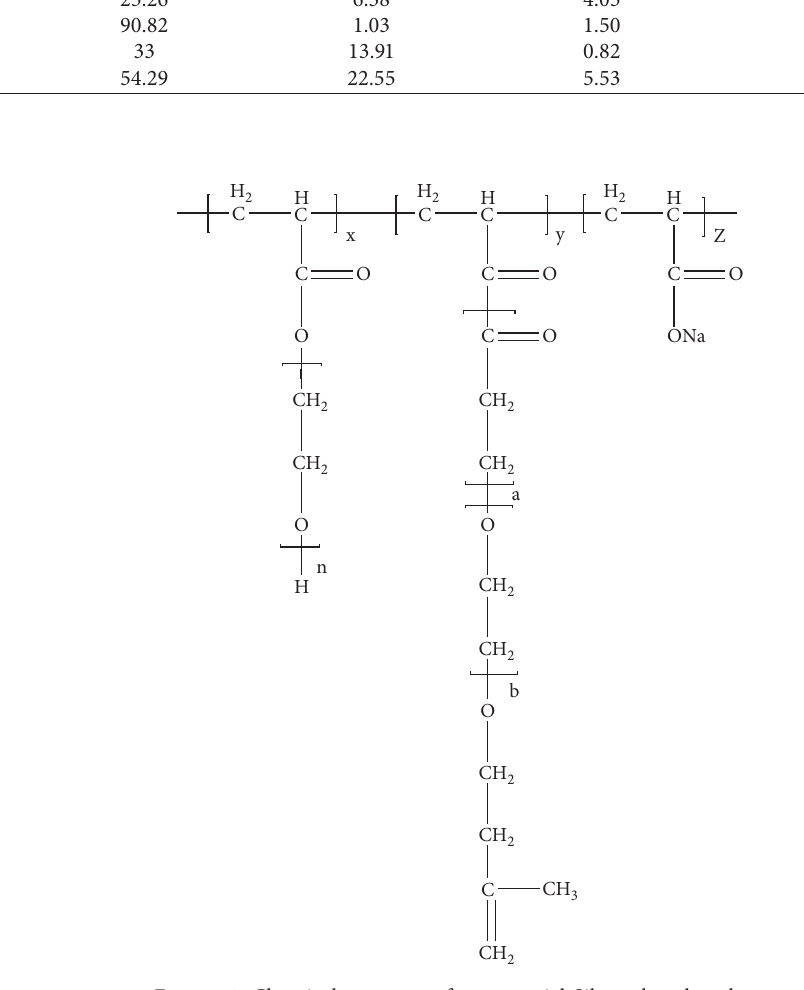
Figure 1: Chemical structure of commercial Sika polycarboxylate.